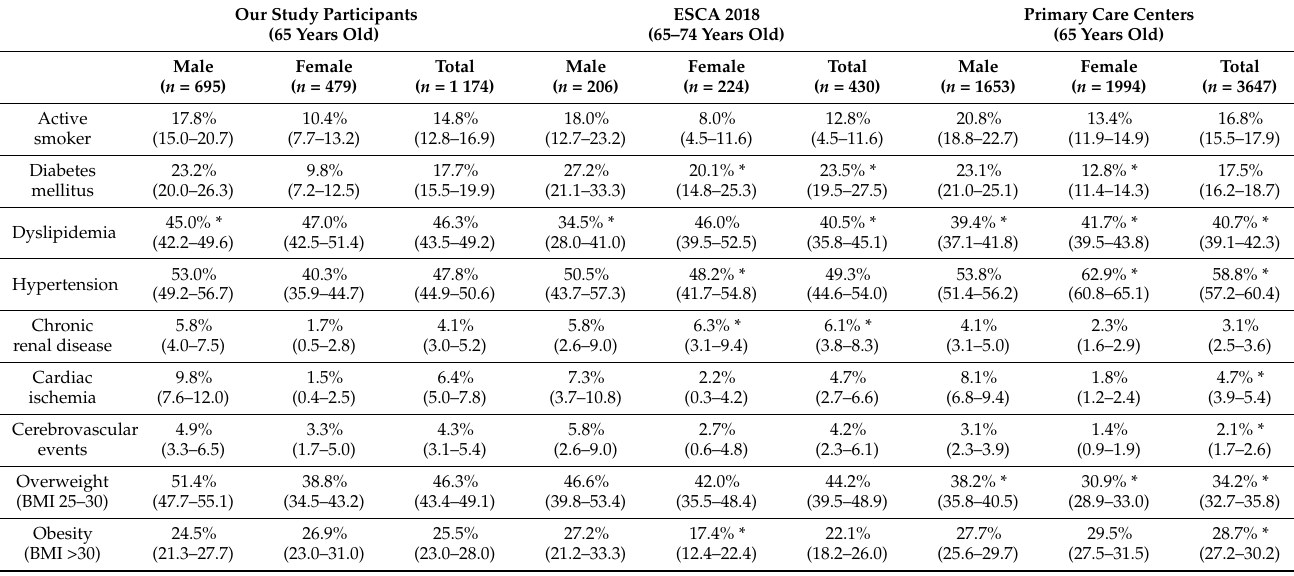
Table 5. Characteristics of our study participants and participants of Catalunya Health Survey 2018 (ESCA) and primary care centers of our region of study separated by